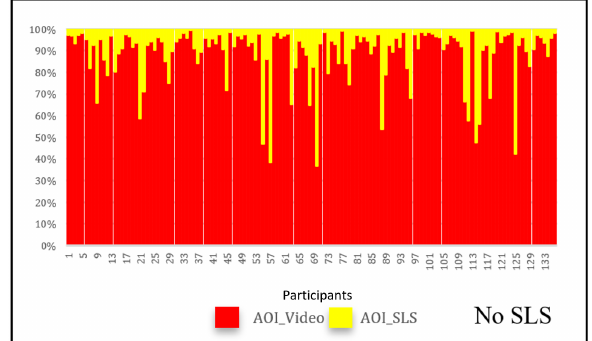
Figure 6: Percentage of fixations in video without SLS